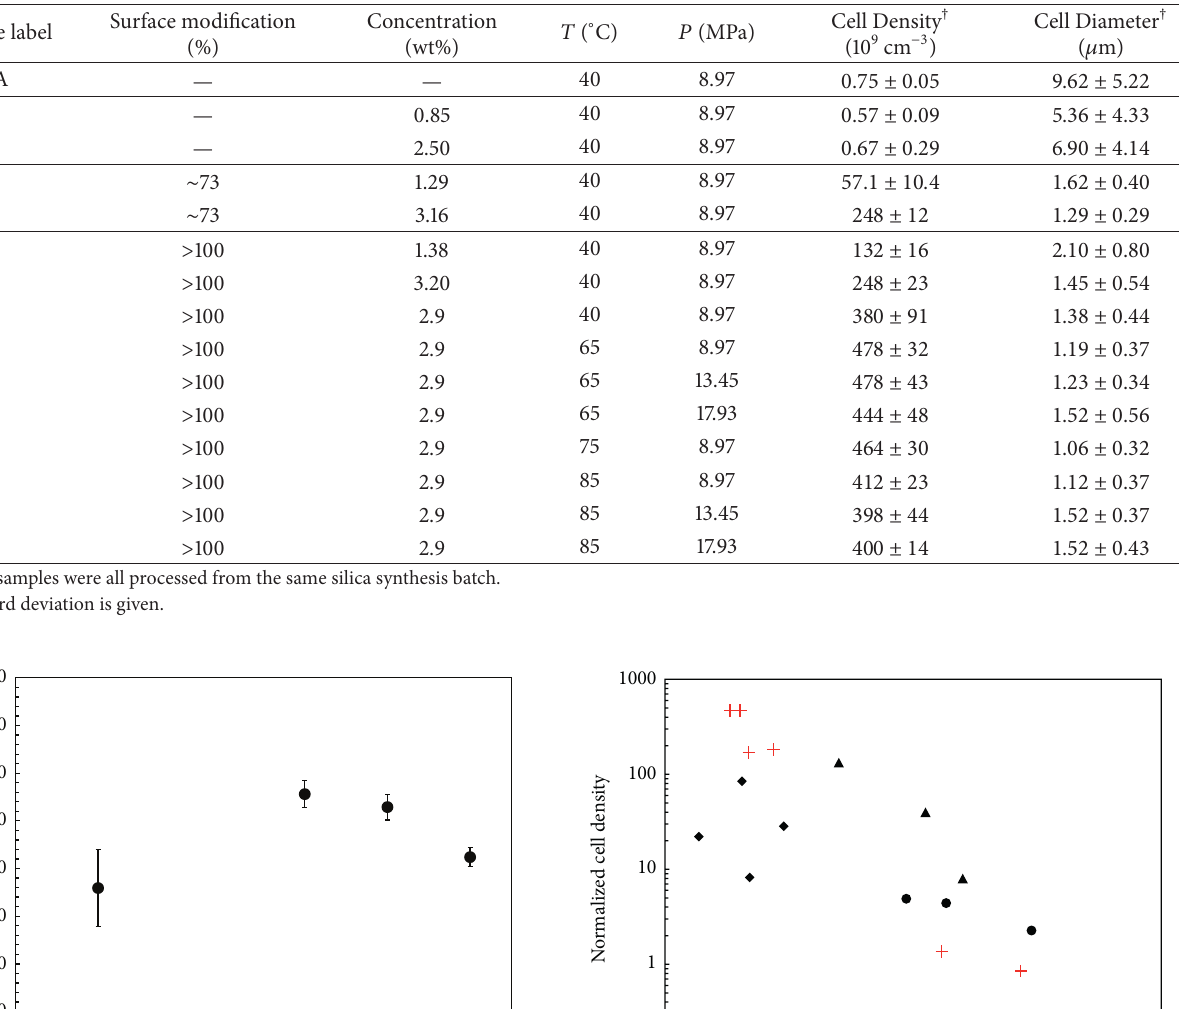
Table 2: Summary of the cell density and cell size measurements for all samples used in the current study. T is the foaming temperature and P is the saturation pressure.